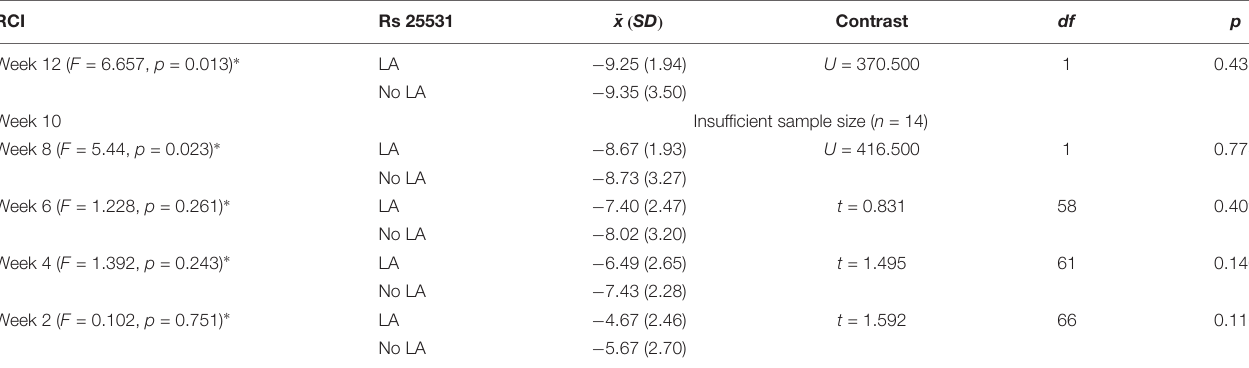
TABLE 6 | Mean, SD, bivariate analysis ( t -test/ U de Mann Whitney test ), and homogeneity test of the RCI in all the weeks and the variable Rs 25531. RCI Rs 25531 ¯ x ( SD ) Contrast df p Week 12 ( F = 6.657, p = 0.013)